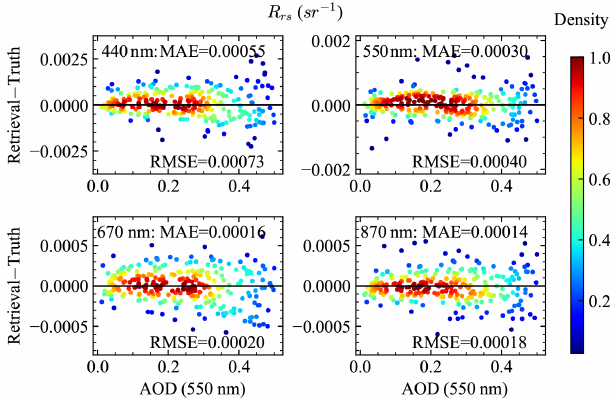
Figure 10. The difference between the retrieval and truth R rs with respect to AOD. The truth R rs is computed with a zenith sun and a nadir viewing direction. The retrieved R rs follows Eq. (10) with the BRDF correction considered. RMSE and MAE are for all retrievals cases at each